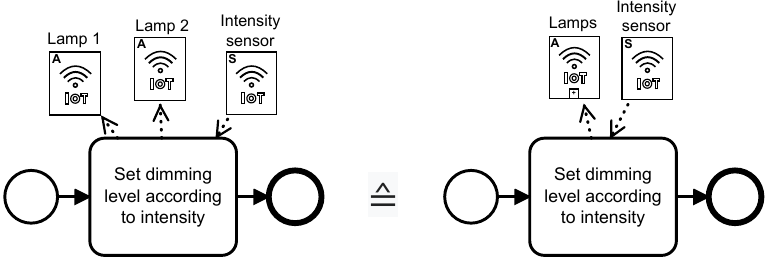
Figure 6. Usage of Actuator Artifact and Actuator Group